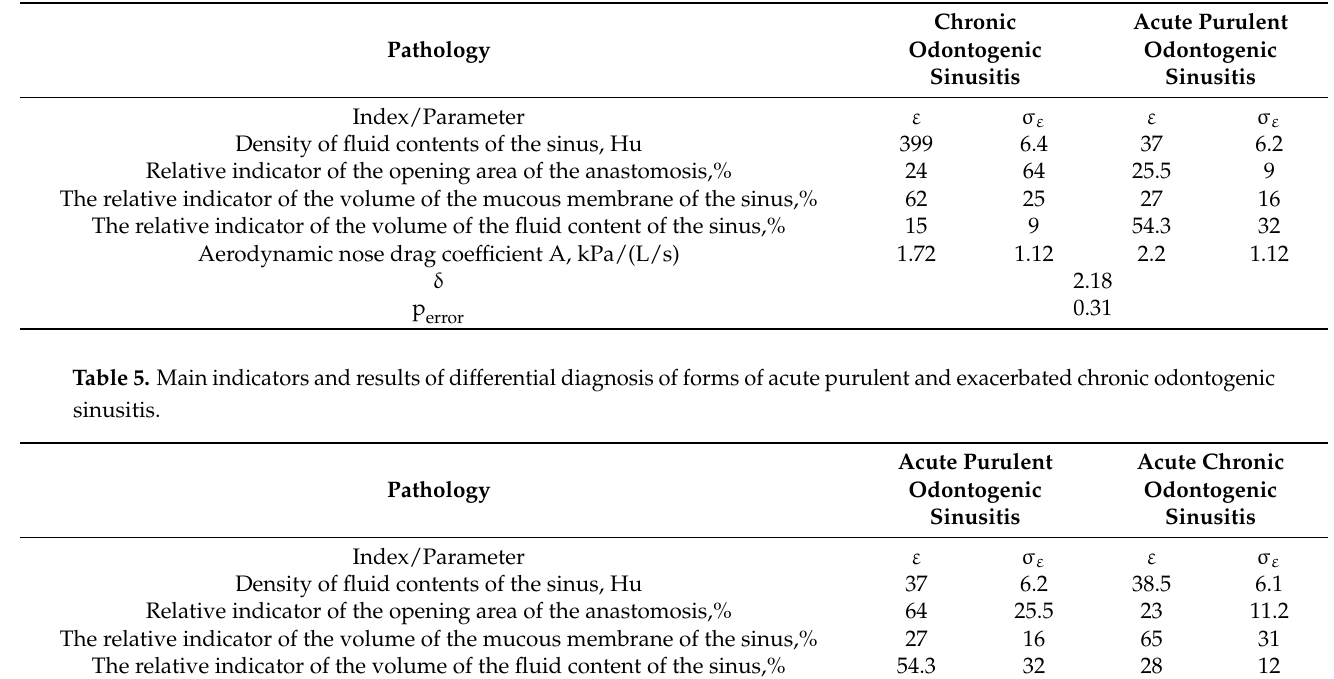
Table 4. Main indicators and results of differential diagnosis of forms of chronic and acute purulent odontogenic sinusitis.